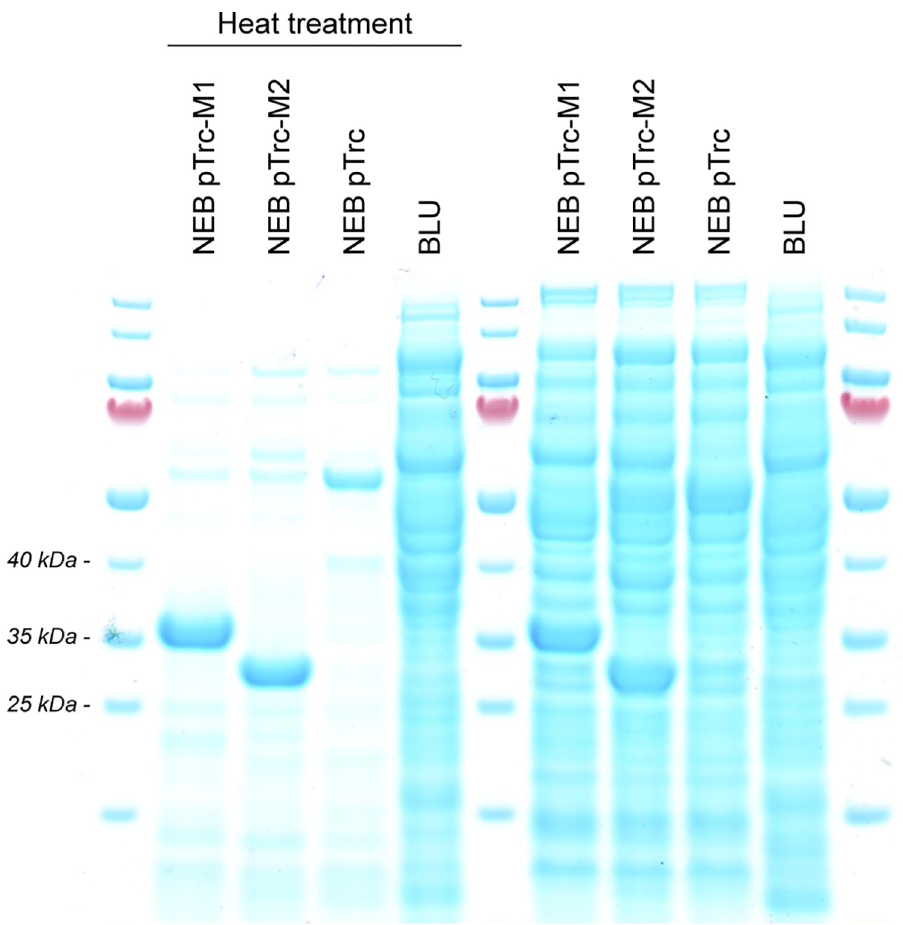
Fig 3. SDS-PAGE analysis of protein extracts from E . coli NEB 10-beta strains expressing methyltransferases M1. Cal02329 and M2.Cal02329. Protein extracts were prepared from E . coli strain NEB 10-beta pTrc-Ec_cal02329M1 (NEB pTrc-M1), E . coli strain NEB 10-beta pTrc-Ec_cal02329M2 (NEB pTrc-M2), E . coli strain NEB 10-beta pTrcHis2 B (NEB pTrc), and Caldicellulosiruptor strain BluCon085 (BLU). Cells were first lysed by sonification, and thermotolerant proteins present in the cell lysates were purified by heat treatment at 70˚C. Protein extracts before and after purification are shown.